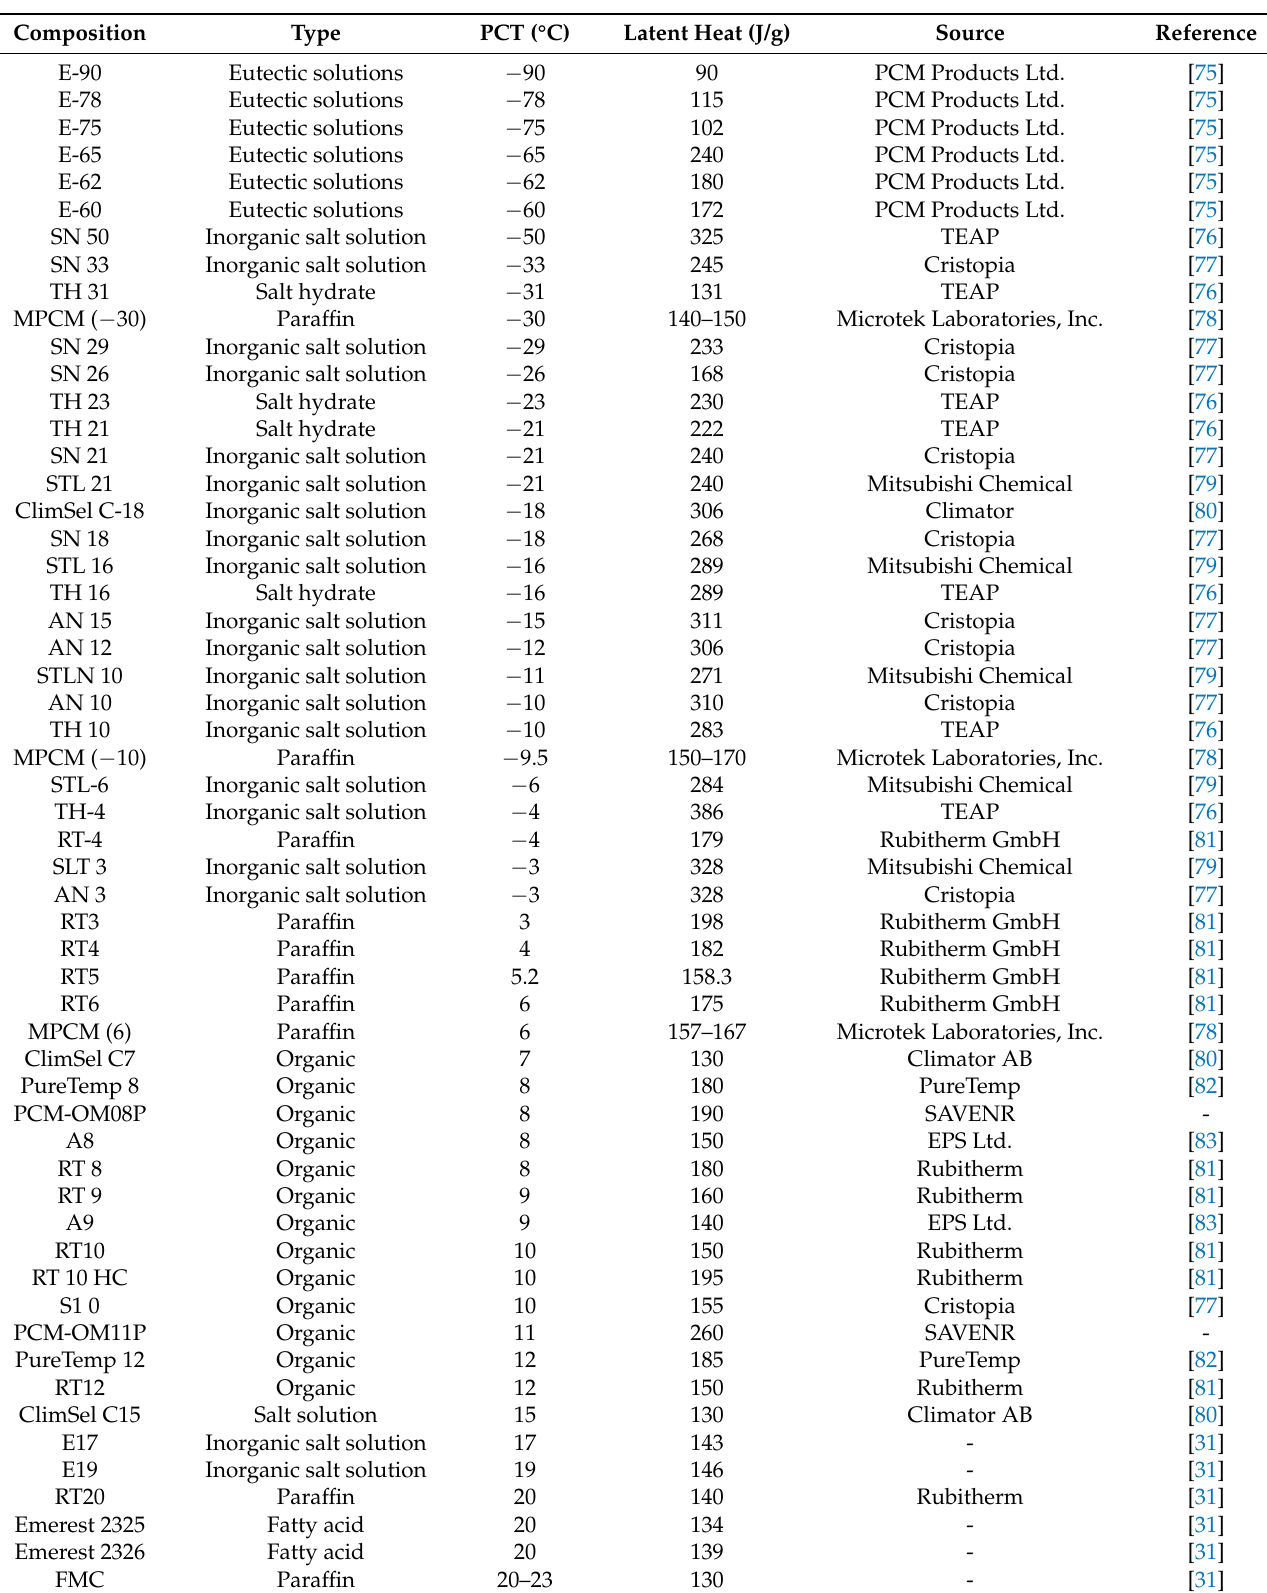
Table 5. Typical commercialized PCMs for